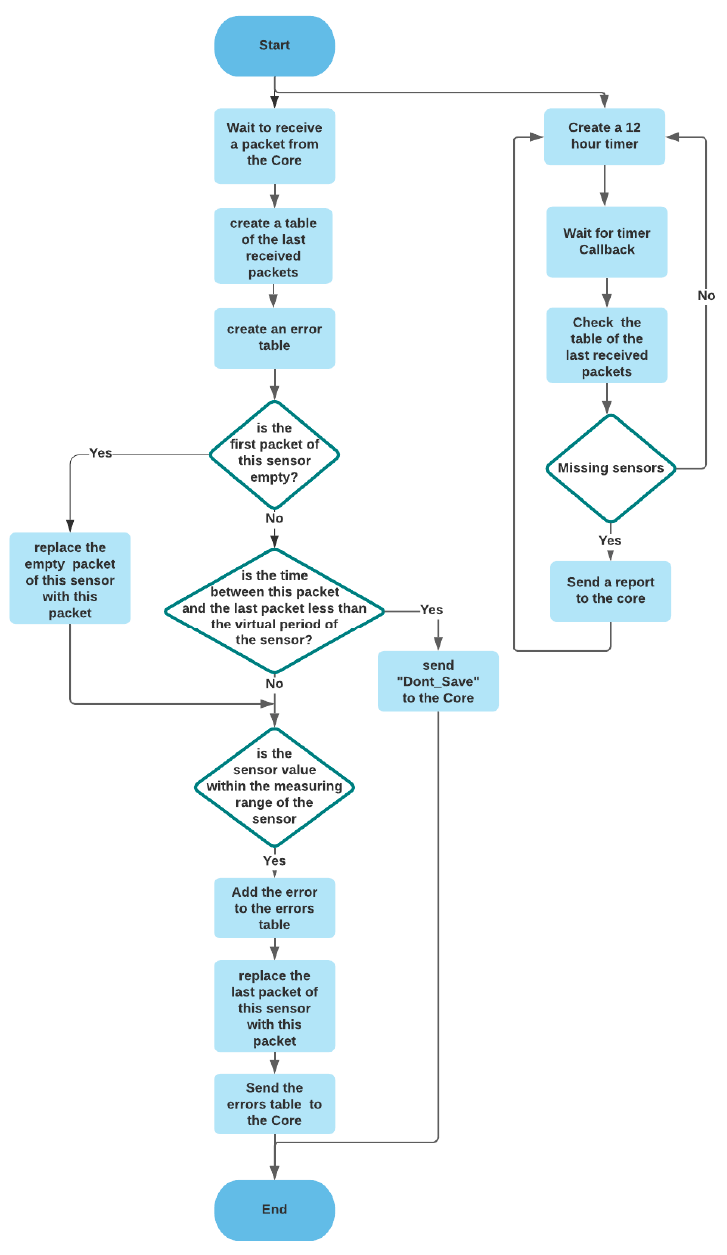
Figure 14. The flowchart the of the detector module.